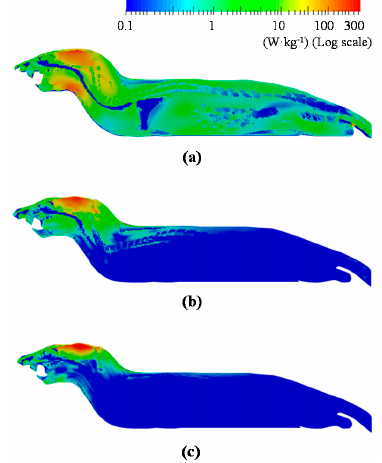
Figure 5. Distributions of SAR: ( a ) 1.5 GHz; ( b ) 6 GHz; and ( c ) 10 GHz. The BASARs correspond to: ( a ) 75 W · kg − 1 ; ( b ) 64 W · kg − 1 ; and ( c ) 79 W · kg − 1 . Exposure durations correspond to: 6 min in ( a ); and 18 min ( b , c ). Int. J. Environ. Res. Public Health 2017 , 14 , 358